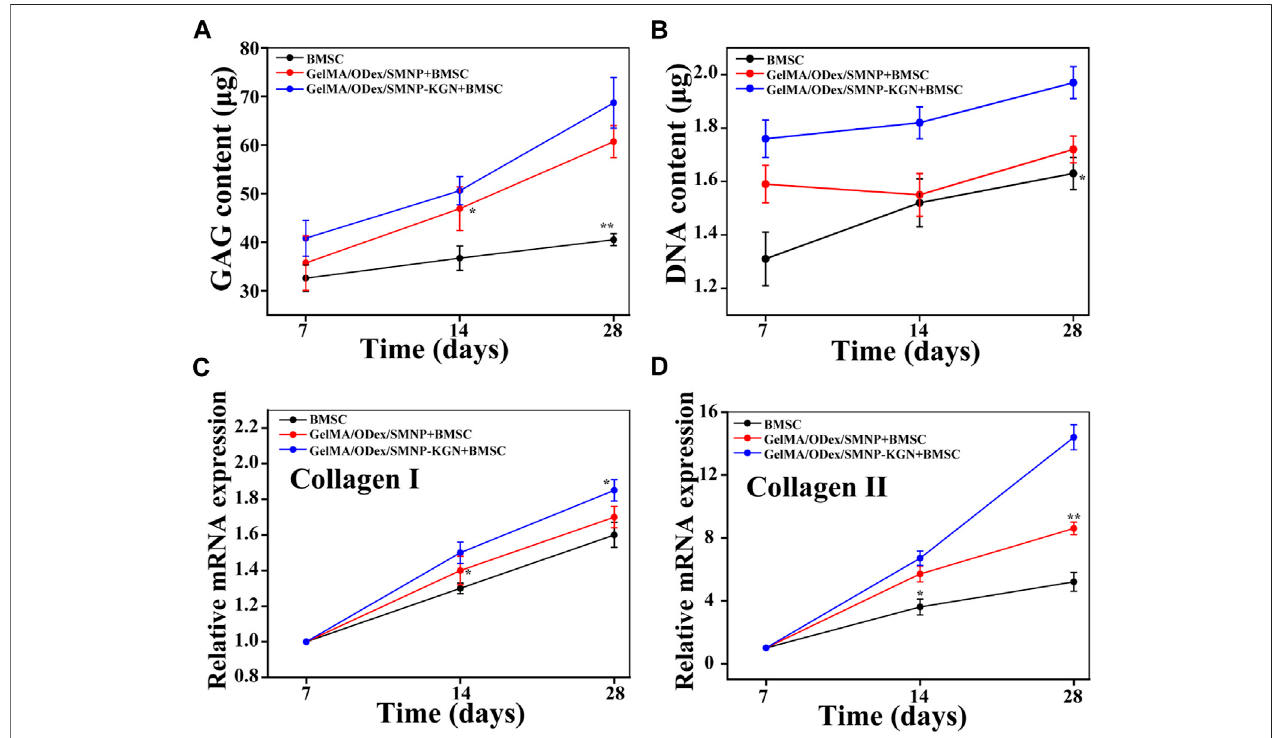
FIGURE 5 | (A) GAG and (B) DNA content of cartilage matrix deposition after BMSCs co-cultured with hydrogel. Relative mRNA expression of (C) collagen II and (D) collagen I.